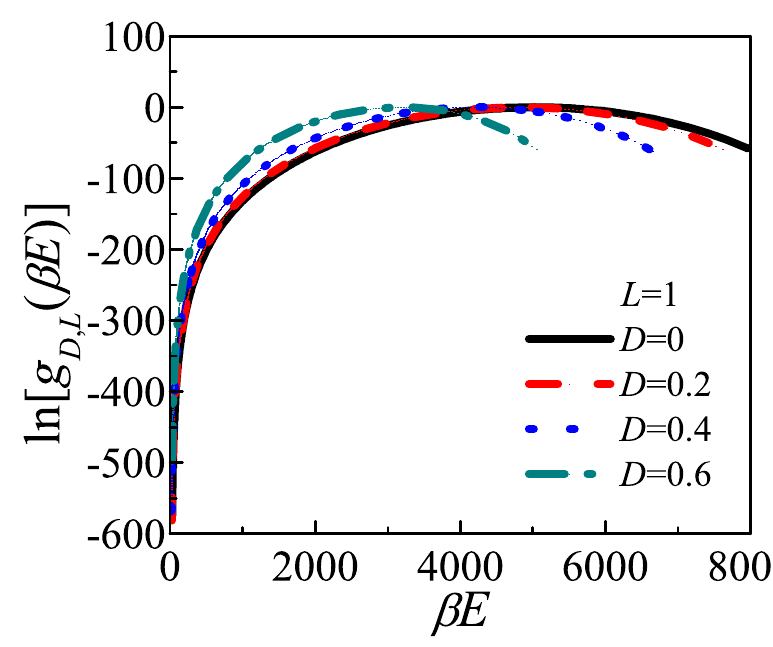
Figure 7. Examples of density of energy states g D , L ( E ) for a series given D when L = 1 is plotted in a logarithmic plot, produced from the Wang–Landau Monte Carlo determination. Black solid line, red dash line, blue dot line, green dash dot line represent D = 0, 0.2, 0.4, 0.6, respectively. The absolute values of g D , L ( E ) and the relative value between different curves are both meaningless, and maximum of g D , L ( E ) curve is chosen to be zero. The range of energy in the case of smaller D is larger than that of larger D , because the ceiling energy of conformation with smaller D is